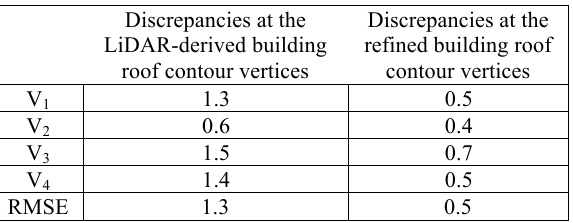
Table 1 - Discrepancies (in meter) between the LiDAR-direved and reference building roof contours and between the refined and reference building roof contours – Example 1